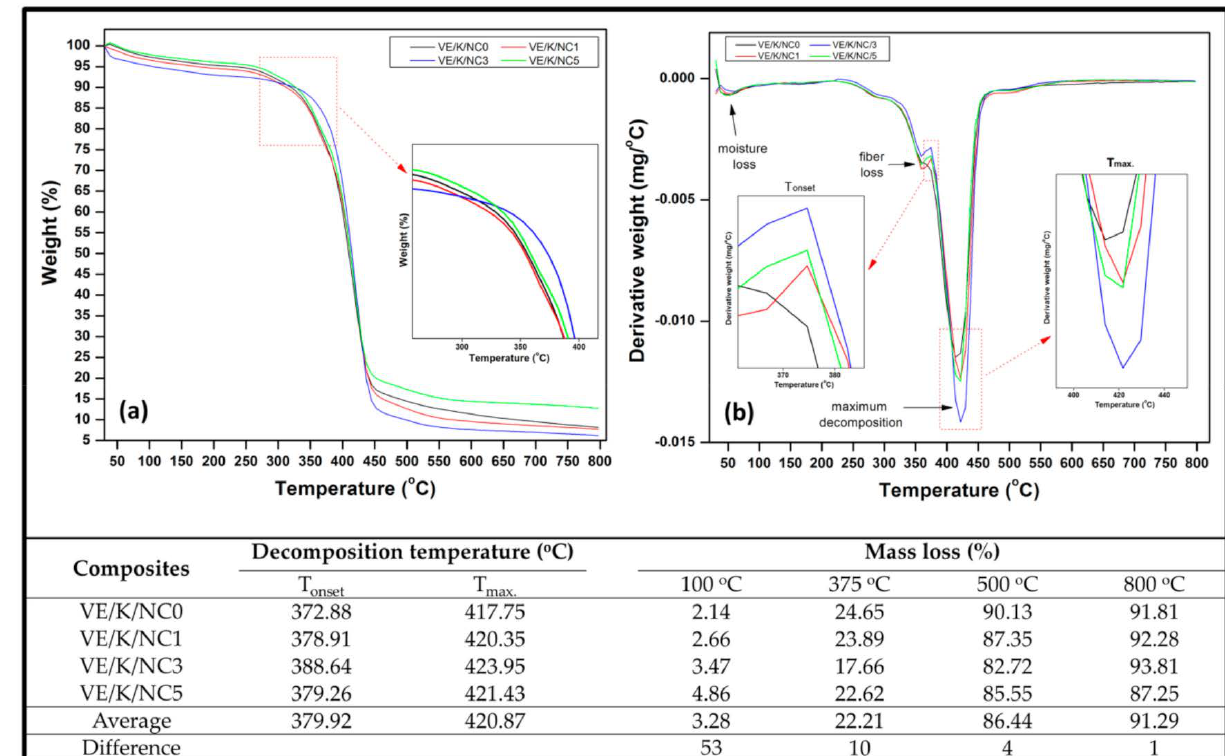
Figure 9. Thermogravimetric analysis of nanocomposites ( a ) TGA, ( b ) DTG, decomposition temperature and mass loss data of nanocomposites at different